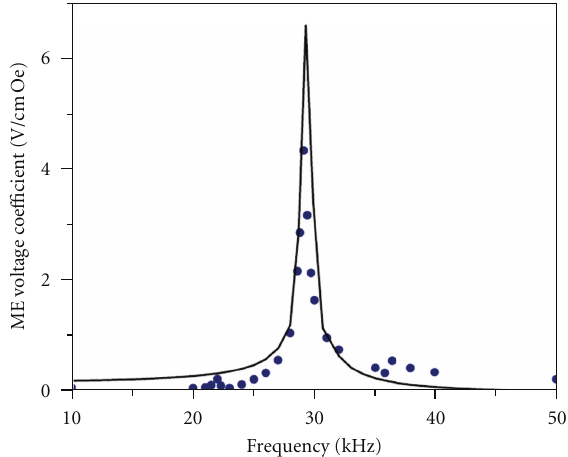
Figure 14: Theoretical (line) and measured (circles) frequency dependence of transverse ME voltage coe ffi cients for a permendur- PZT bilayer that is free to bend at both ends and with v = 0 .